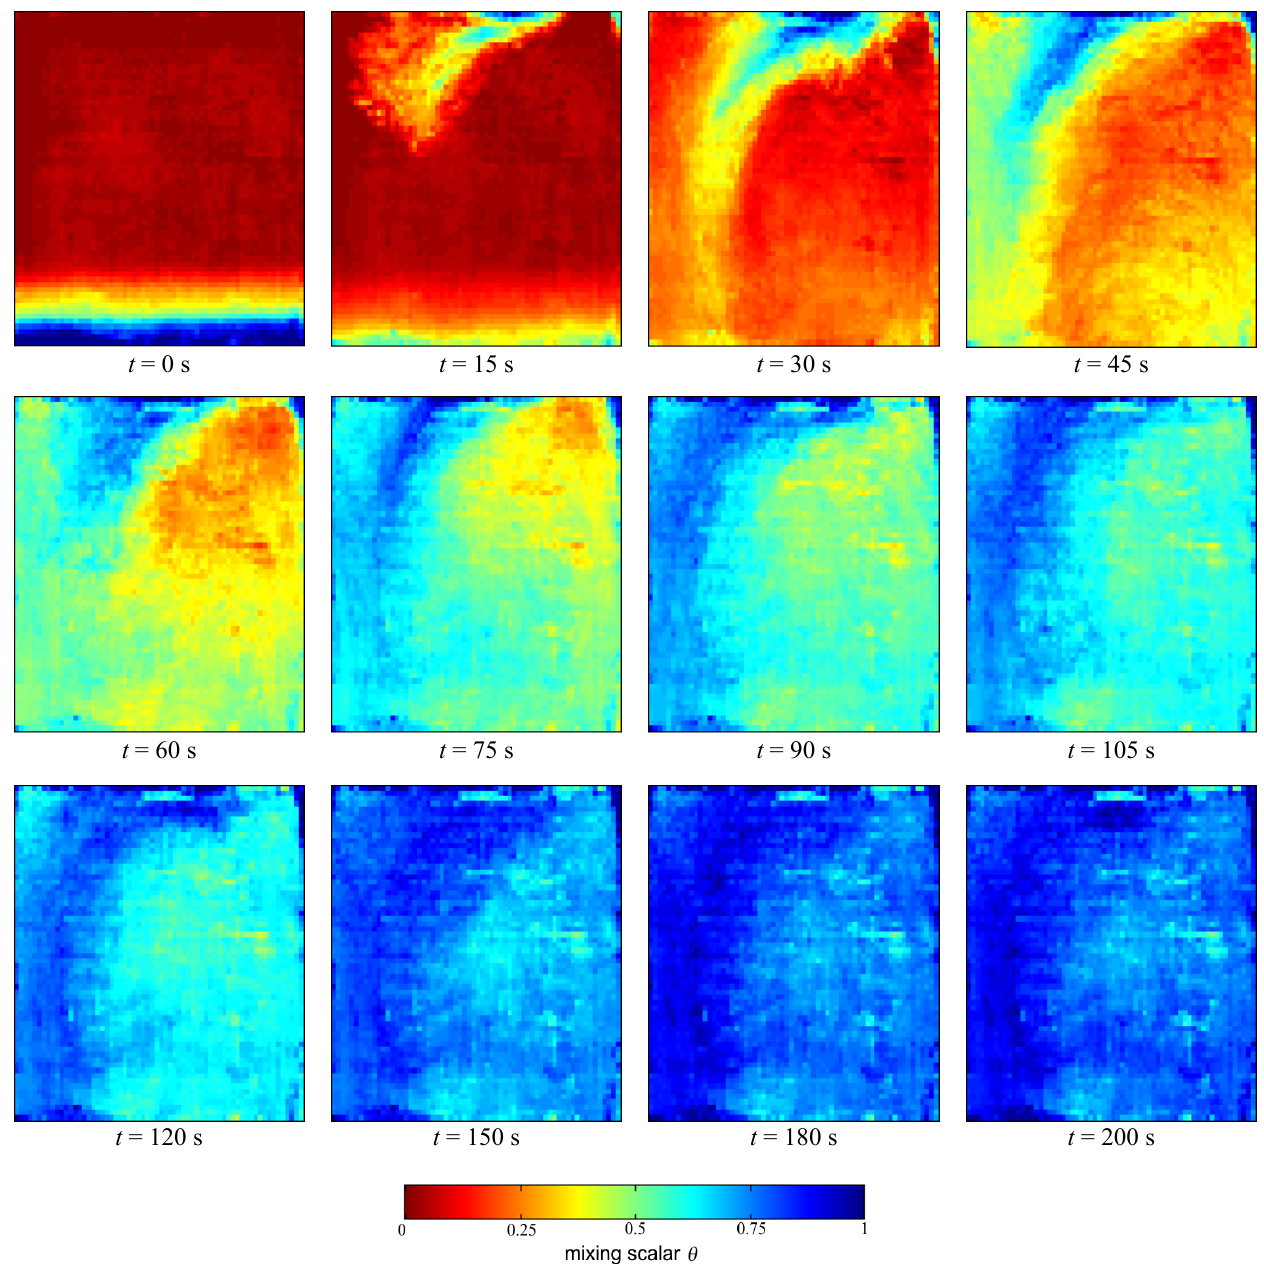
Figure 7 . Instantaneous images of the mixing scalar θ . For details about the experiment see